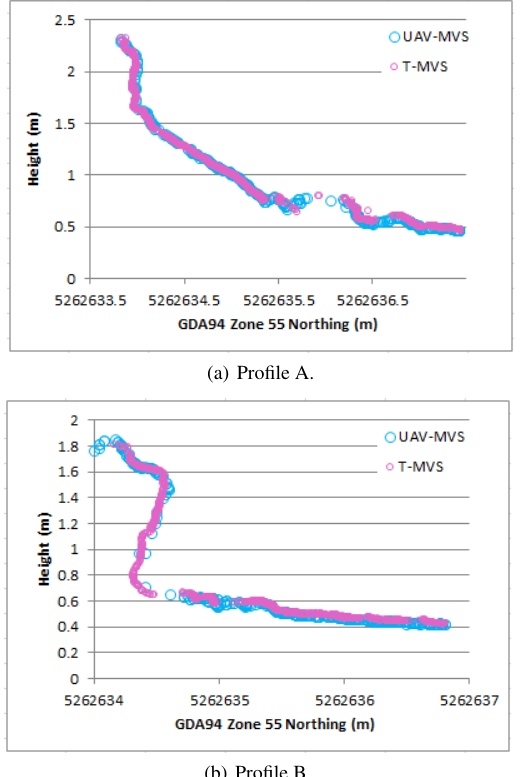
Figure 6: A 1 cm wide profiles of the UAV-MVS and T-MVS point